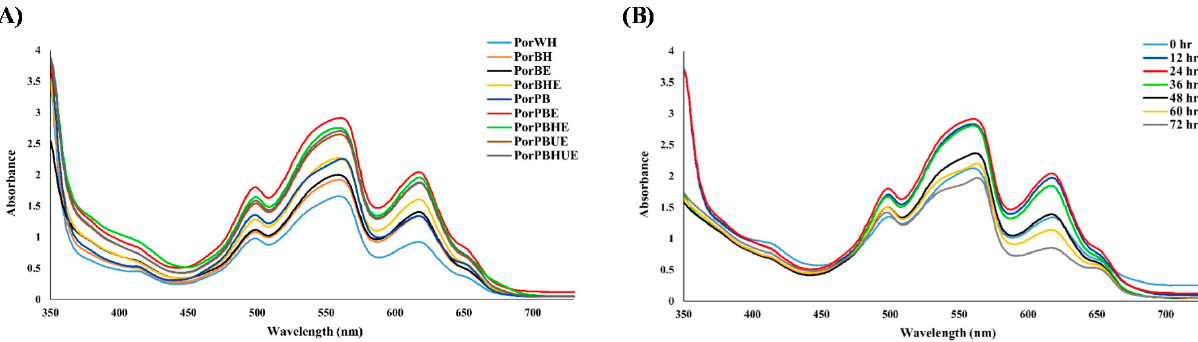
Figure 2. UV-visible absorbance spectrum of dry Porphyra and Porphyra powder extracted by ( A ) different solvents or different assisted extraction methods at 26 °C for 24 h, and ( B ) Porphyra powder extracted by sodium-phosphate buffer containing 15% MA103 crude enzyme solution and 15% MAEF108 crude enzyme solution (PorPBE) for 0–72 h. Each line indicates the sample of dry Porphyra or Porphyra powder extracted by a specific method as described in the Materials and Methods.